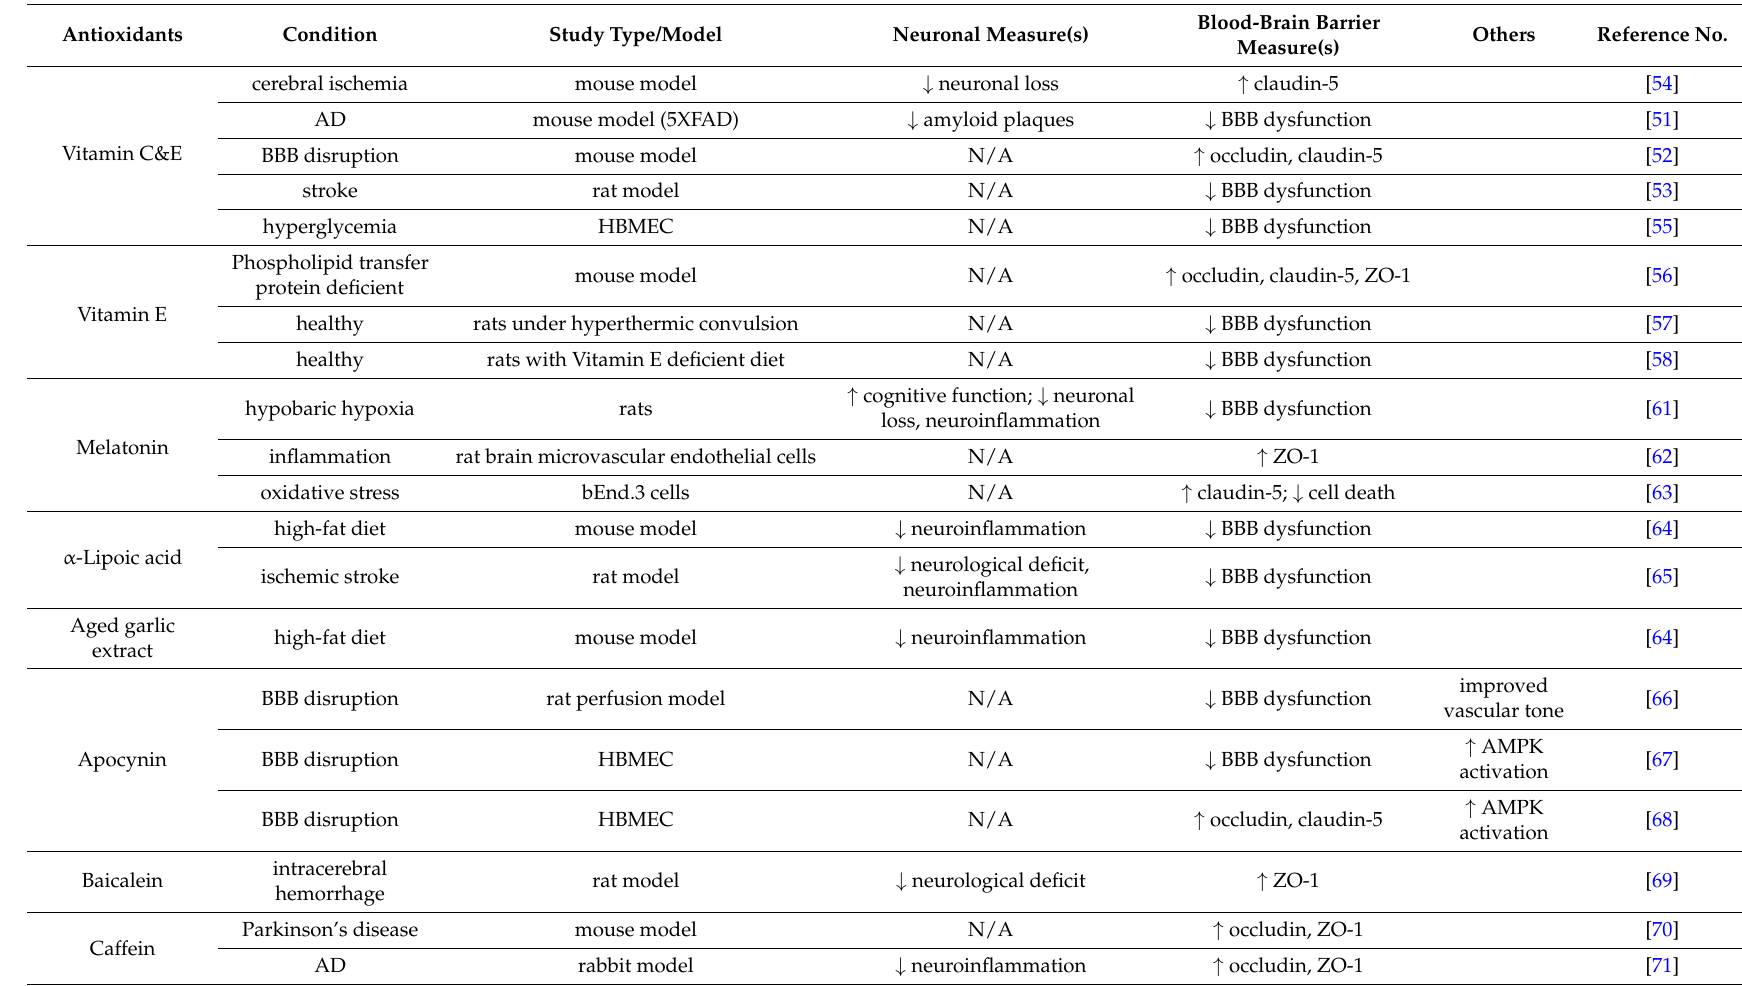
Table 1. Literature